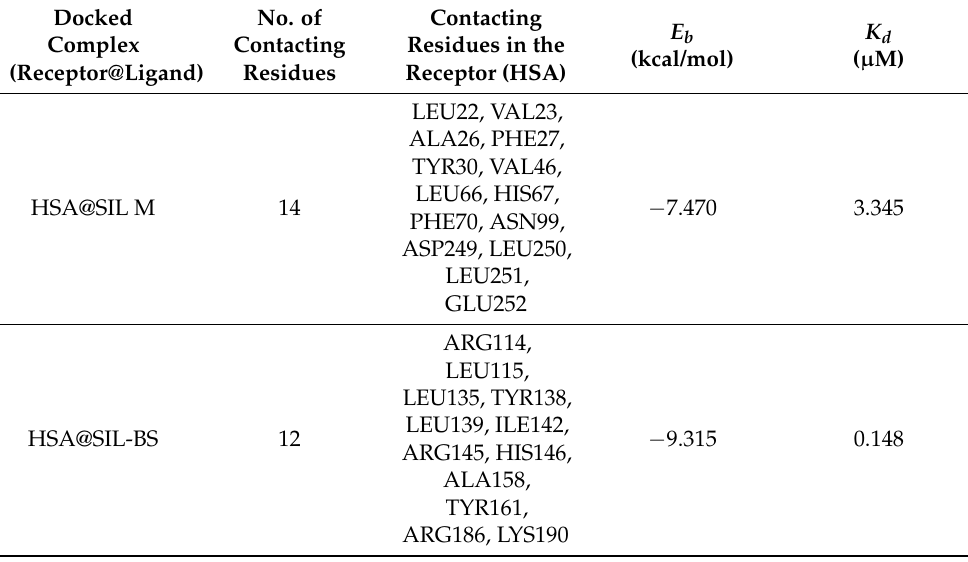
Table 4. Contacting receptor residues in docked complexes (by studied ligands SIL-M and SIL-BS), and calculated affinity estimators (relative binding energy and dissociation constant).